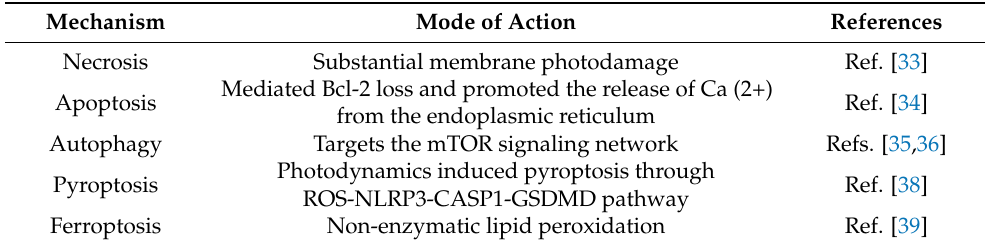
Table 1. PDT-induced cell death modality and